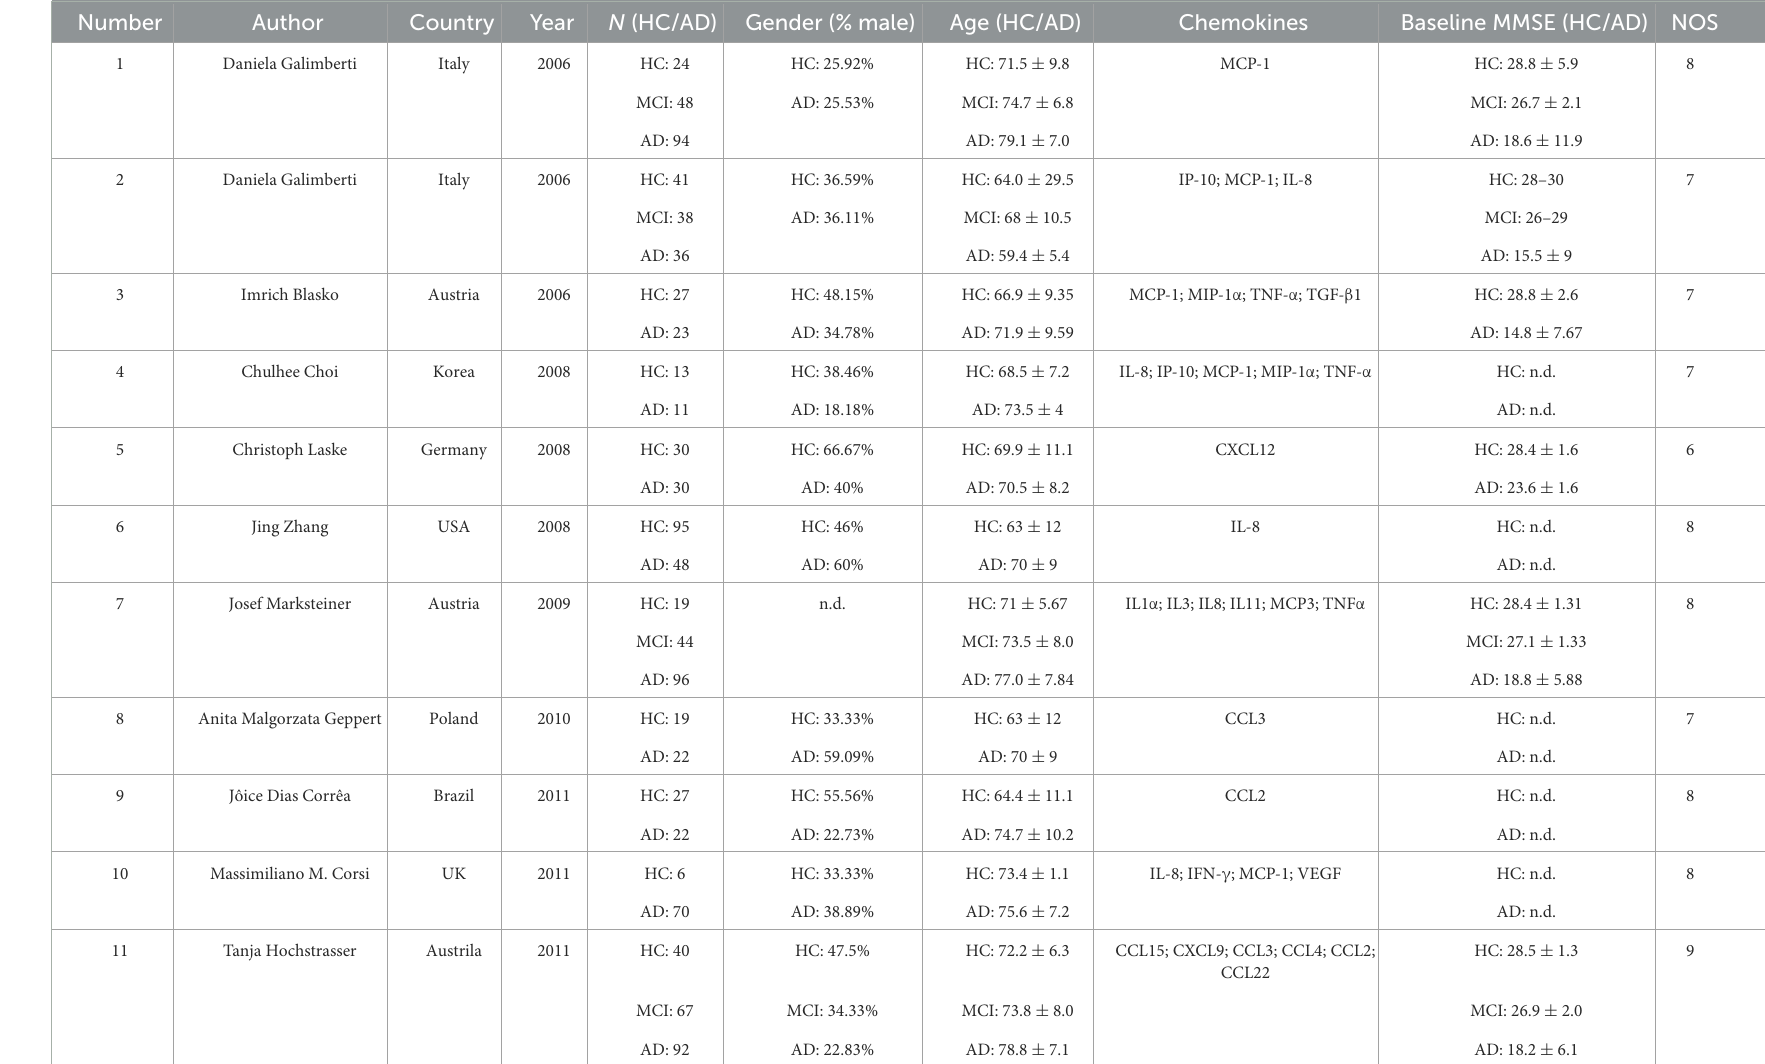
TABLE 1 Baseline characteristics of the included